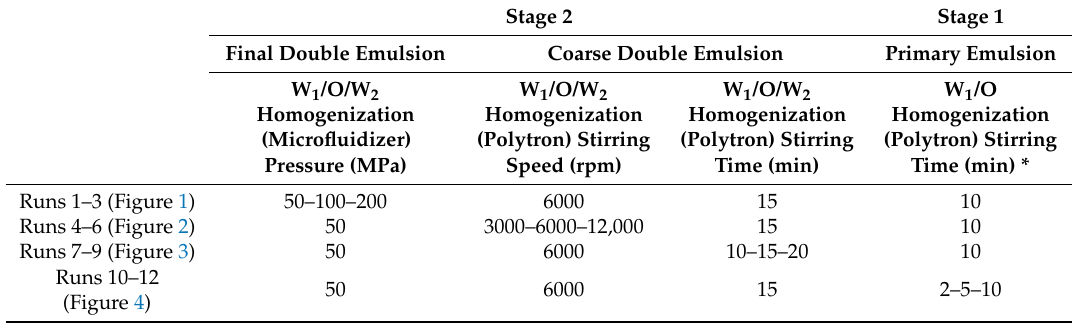
Emulsion composition: W 1 /O: 76 g corn oil, 4 g PGPR, 20 g of aqueous blueberry pomace extract (W 1 ); W 1 /O/W 2 : 30 g